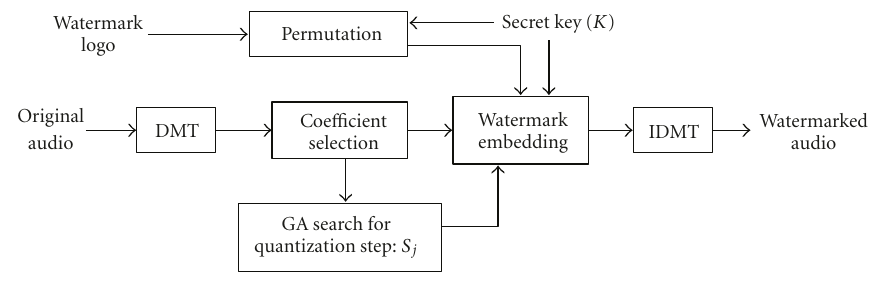
Figure 4: Watermark embedding process.